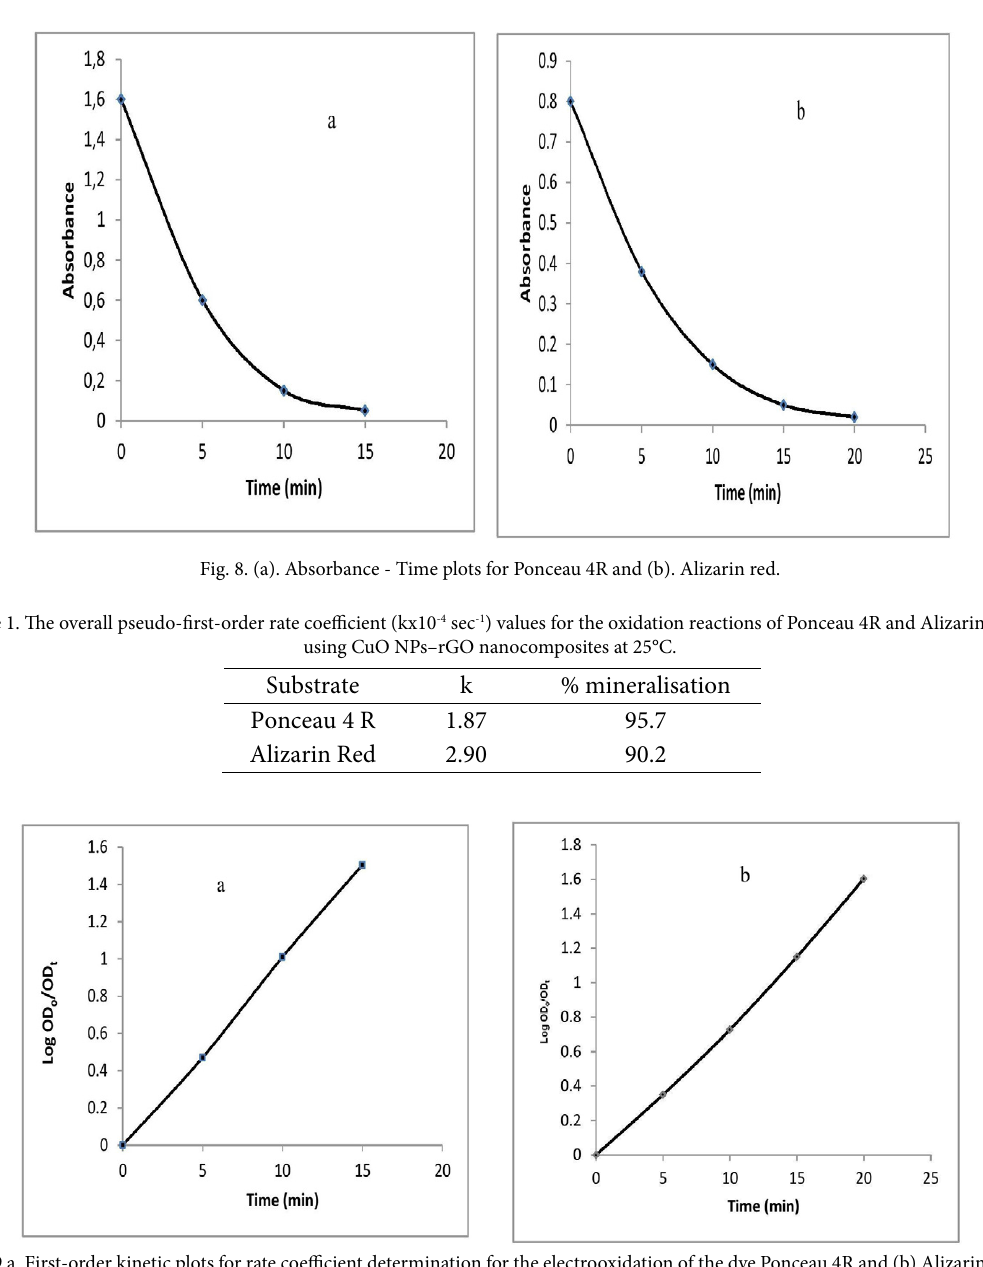
Fig. 9.a. First-order kinetic plots for rate coefficient determination for the electrooxidation of the dye Ponceau 4R and (b) Alizarin